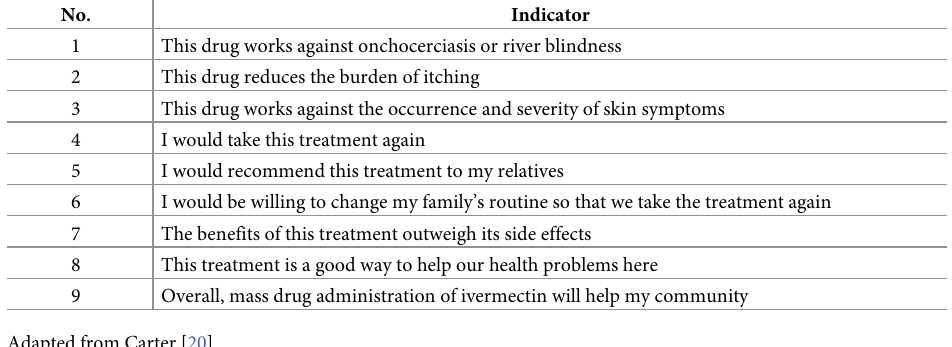
Table 1. The nine acceptability indicators combined to form the acceptability score.